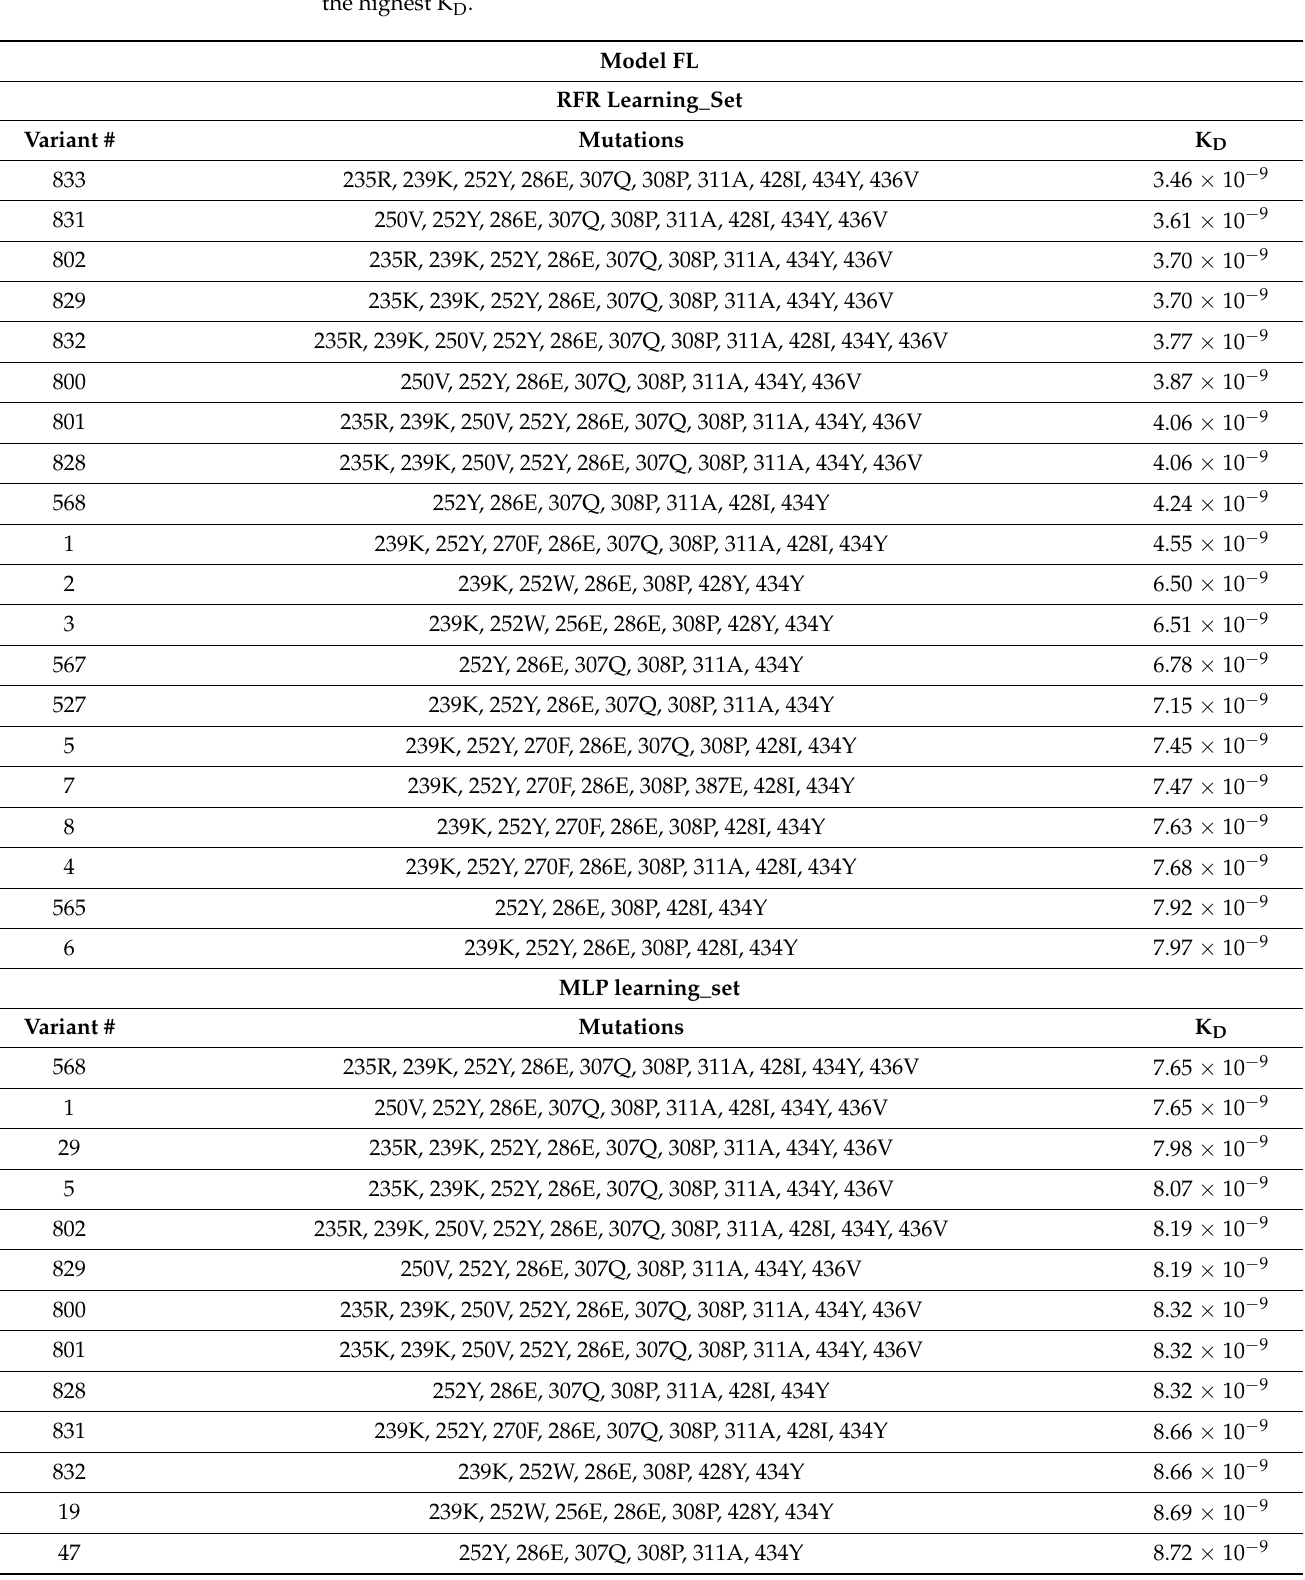
Table A3. For the two different models and the four different algorithms, 20 variants predicted with the highest K D